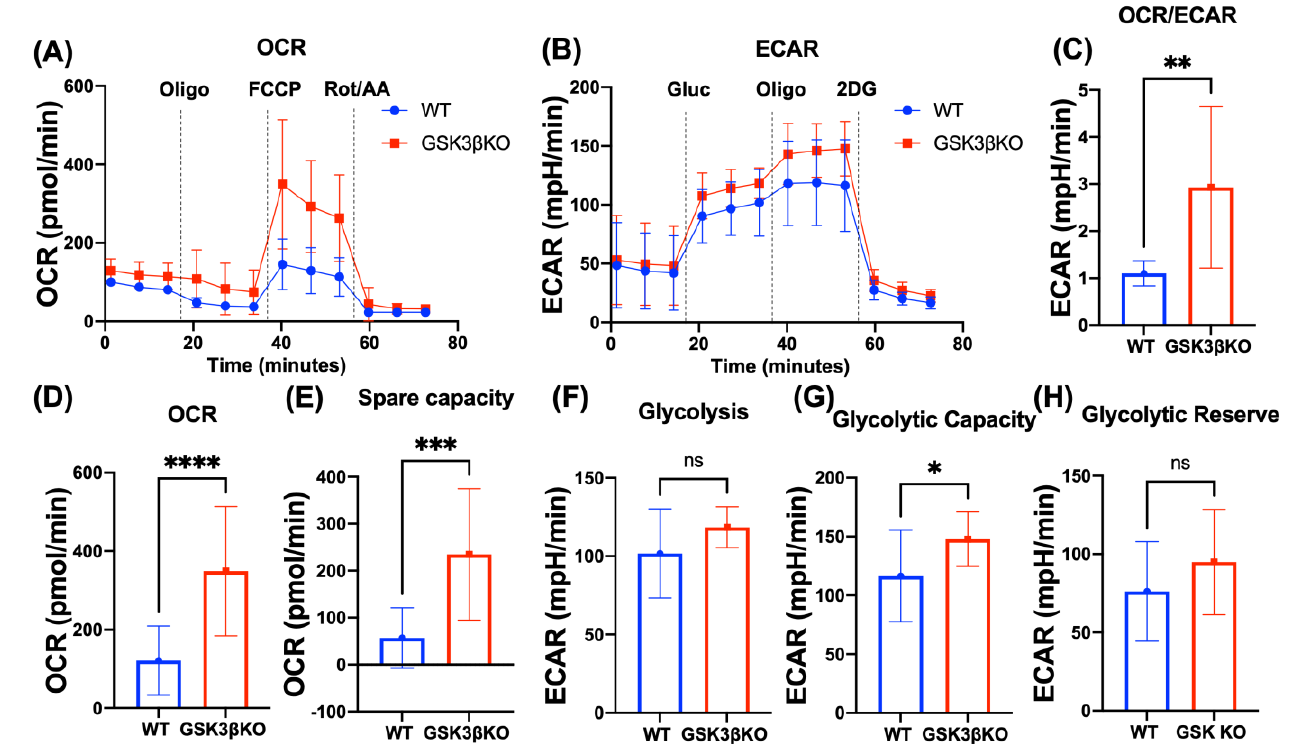
Figure 4. Deletion of GSK3B enhances metabolic capacity of NK cells. ( A , B —mitochondrial and glycolytic stress, respectively) summarized data of metabolic analysis of paired WT and GSK3B -KO NK cells ( n = 3; mean ± SD). ( C ) OCR/ECAR ratio. ( D ) Maximum respiratory capacity. ( E ) reserve capacity derived from ( A ). ( F ) Glycolysis, ( G ) glycolytic capacity, and ( H ) glycolytic reserve derived from ( B ). n = 4, ns = non-significant, * p ≤ 0.05, ** p ≤ 0.01, *** p ≤ 0.001, **** p ≤